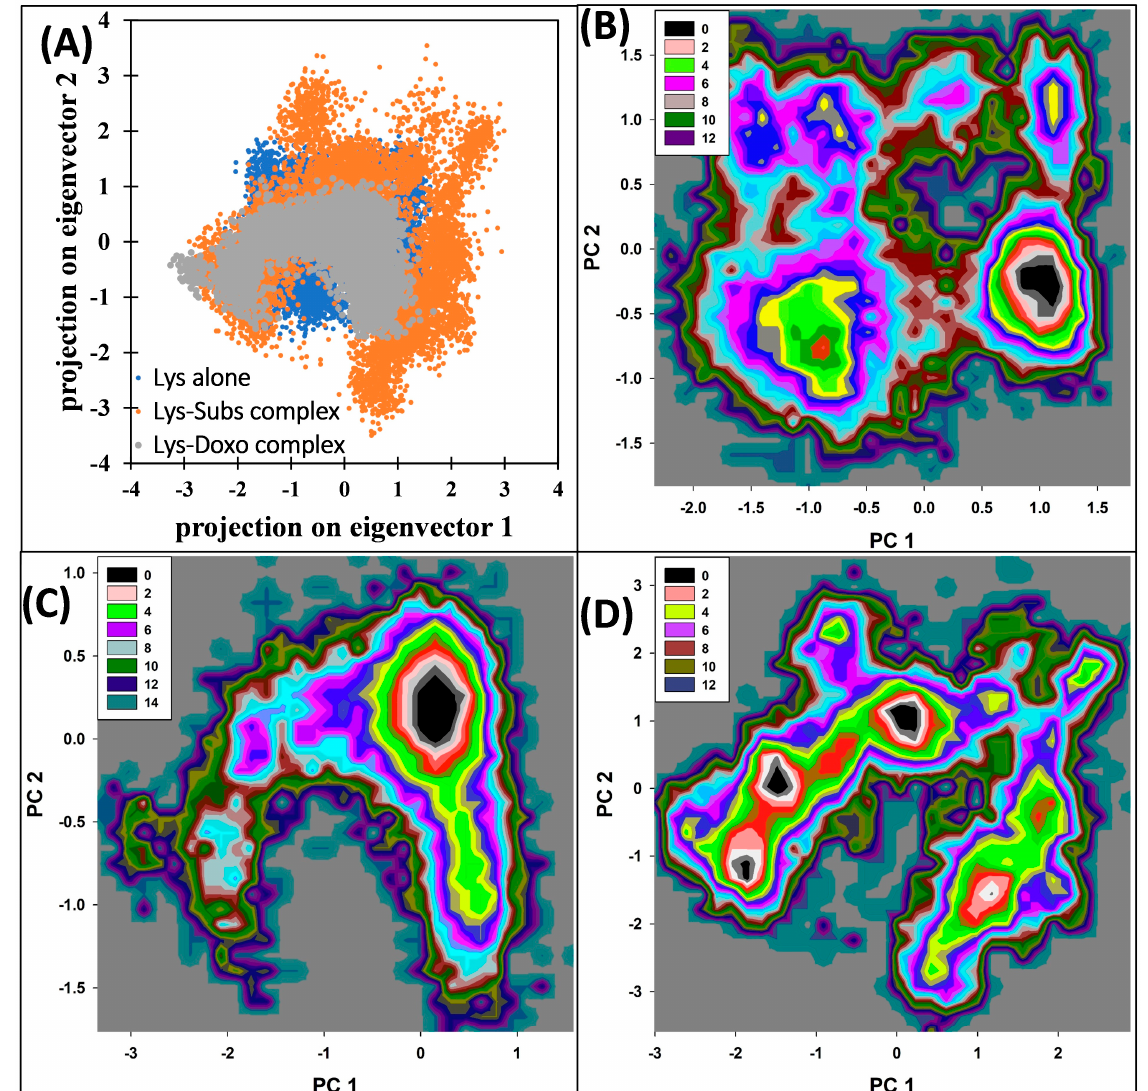
Figure 9. Principal component analysis: ( A ) Scatter plot of all trajectory frames of the backbone atoms of lysozyme alone, lysozyme–substrate complex, and lysozyme–doxofylline complex of the first two principal eigenvectors (PC1 and PC2). ( B ) Gibbs free energy landscape of lysozyme alone obtained from PCA analysis. ( C ) Gibbs free energy landscape of lysozyme–substrate complex obtained from PCA analysis. ( D ) Gibbs free energy landscape of lysozyme–doxofylline complex obtained from PCA analysis.